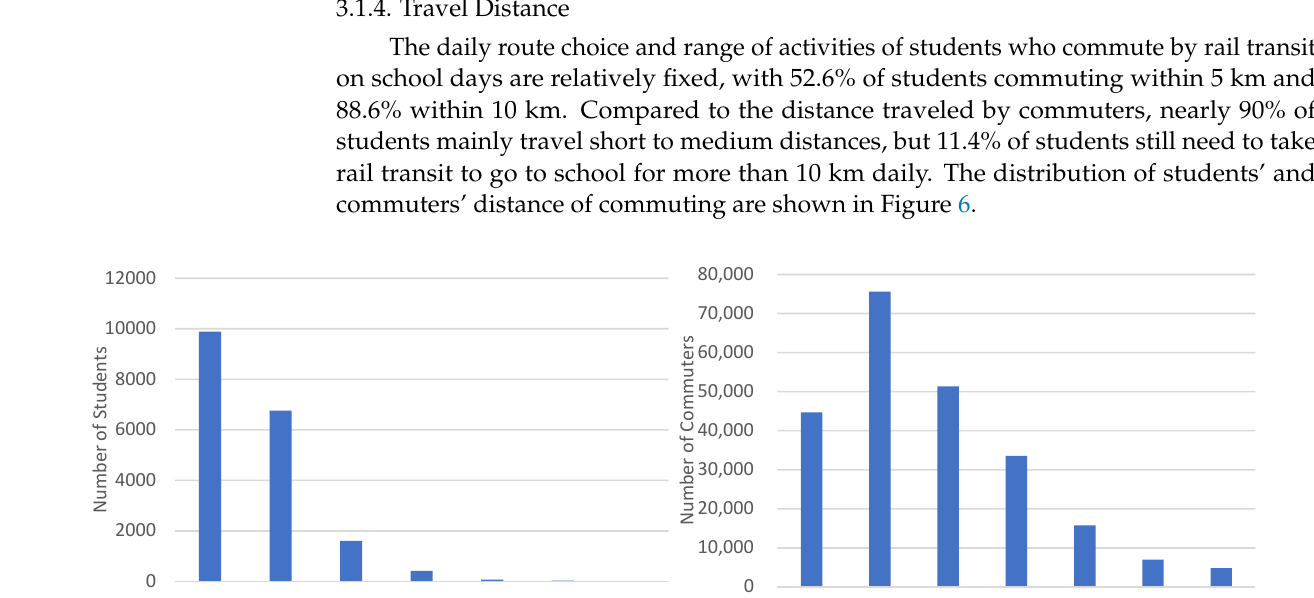
Figure 5. Distribution of students’ and commuters’ length of commuting. ( a ) Distribution of students’ length of commuting; ( b ) Distribution of commuters’ length of commuting.